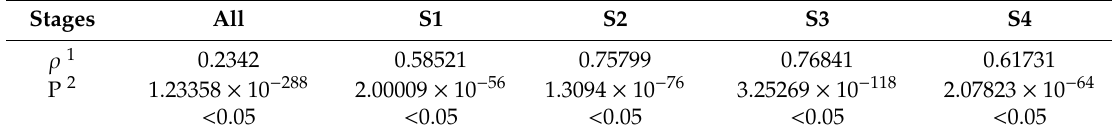
Figure 11. Measurement results of the HR / ST in experiments. Table 7. HR and ST by the Pearson correlation coefficient test.